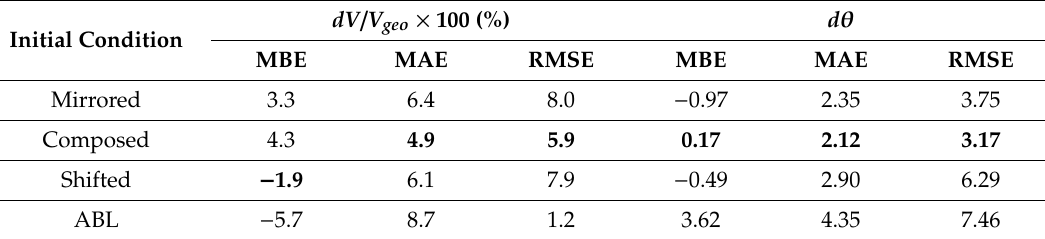
Table 1. Comparison of approximation error of normalized wind speed di ff erence and wind direction di ff erence by the method of generating the initial